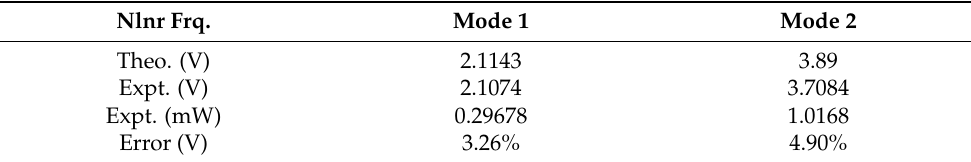
Table 2. Theoretical, experimental and error for the first 2 modes of nonlinear frequency excitation. Nlnr